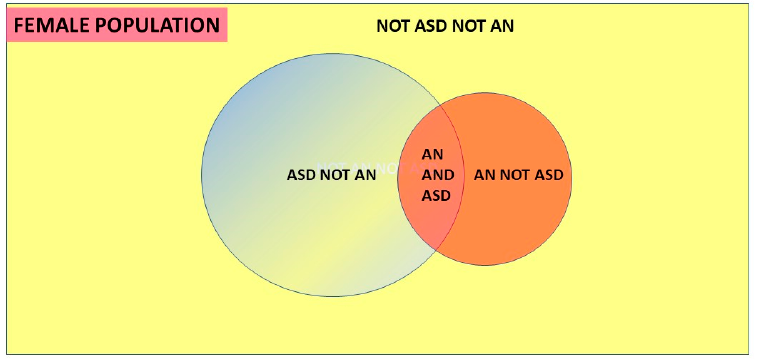
Figure 4. Venn diagram of Bayes’ theorem.